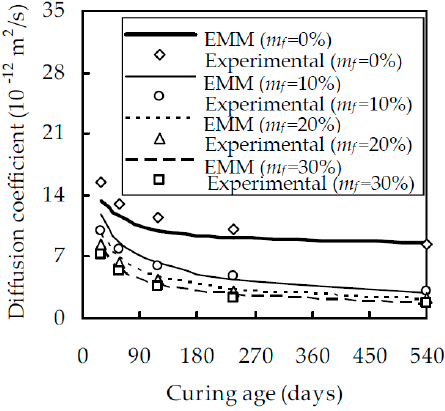
Figure 5. Relationship between D fc and t for fly ash cement paste with w/b of 0.6.